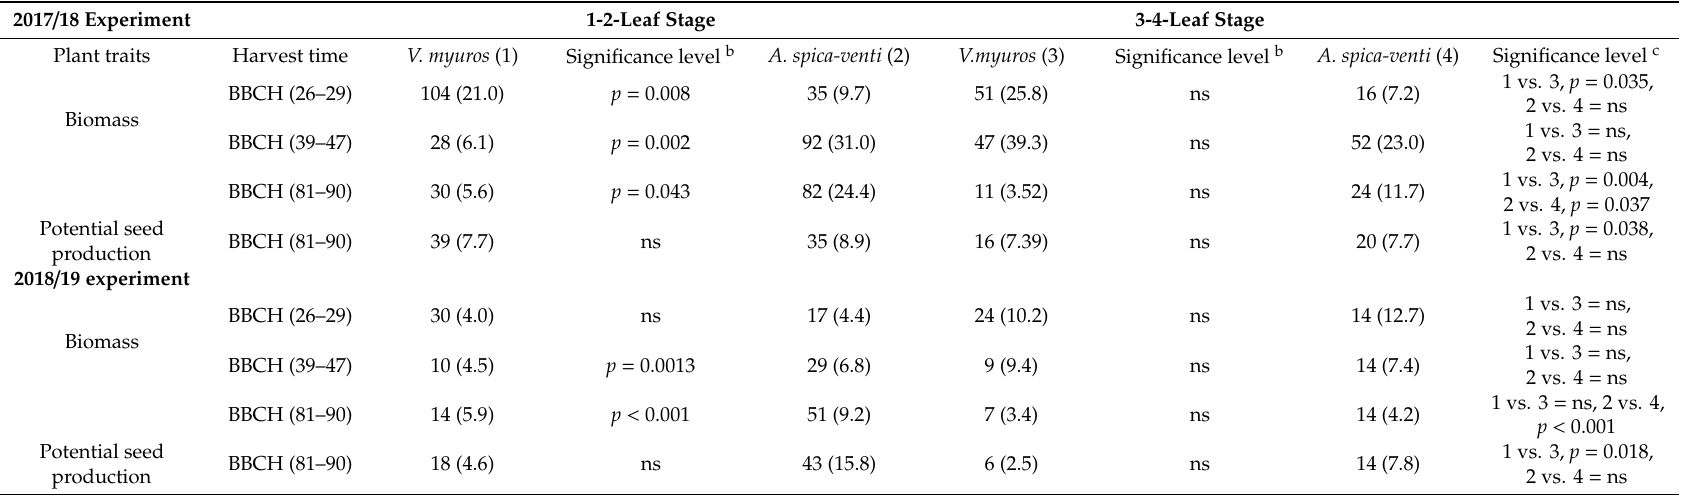
Table 5. The estimated e ff ective density of winter wheat (DENS50) required to suppress 50% responses of V. myuros and A. spica-venti against increasing winter wheat densities at two di ff erent crop growth stages (1–2-leaf stage, 3–4-leaf stage) in 2017 / 18 and 2018 / 19 using a target-neighborhood design. Values in parentheses